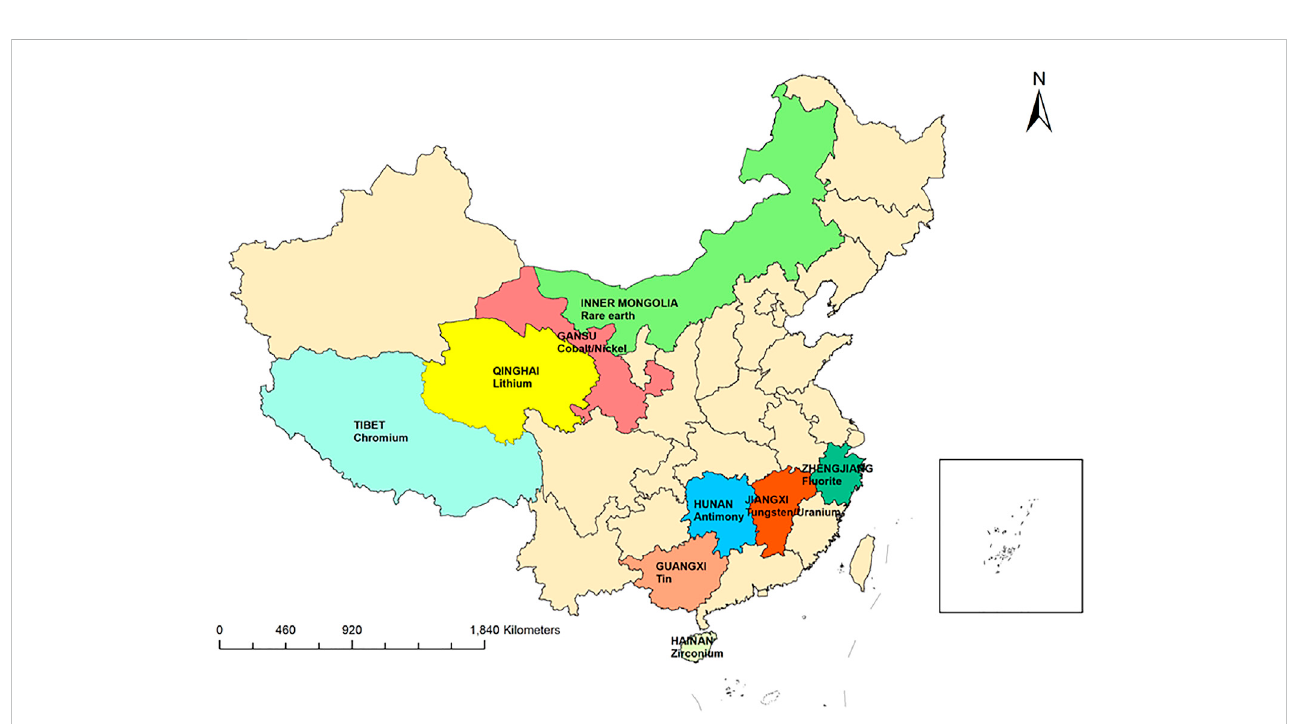
FIGURE 2 Distribution map of 11 strategic and critical minerals in